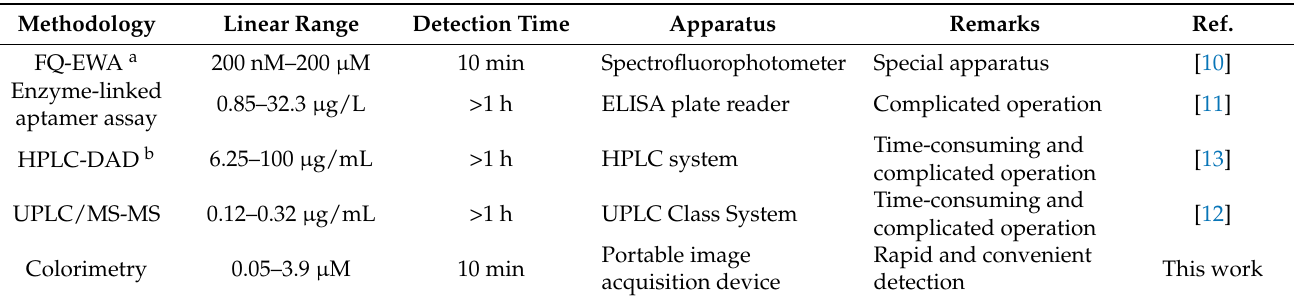
Table 2. Comparison of medical drugs detection